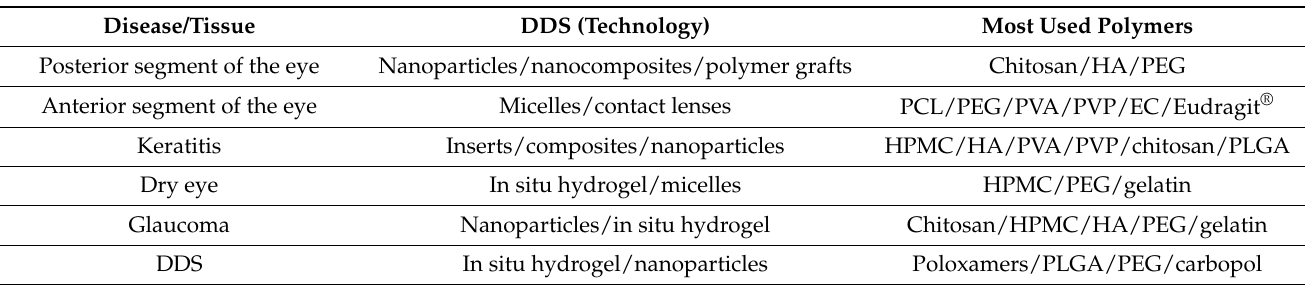
Table 2. Main diseases and/or tissues addressed and the respective polymers used in the proposed delivery